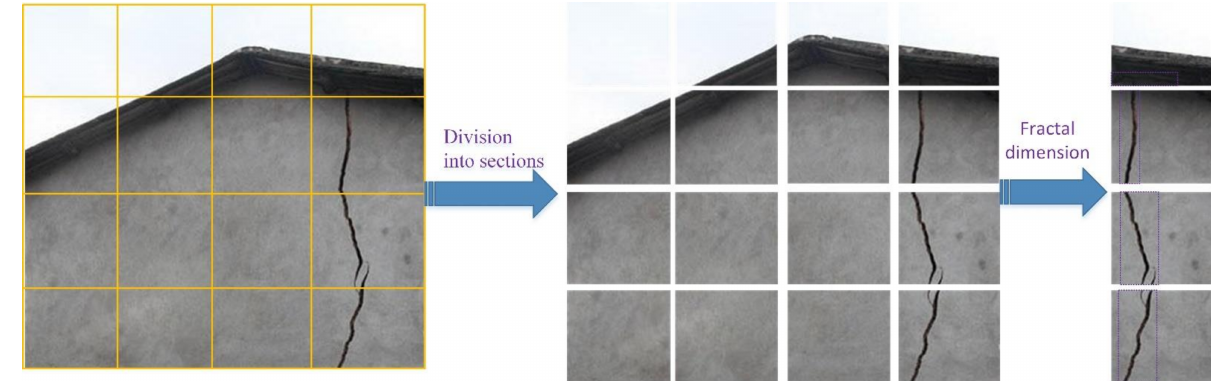
Figure 11. Steps of crack detection of larger area. Therefore, the proposed method mainly includes two steps: initial detection based on fractal dimension and fine segmentation based on UHK-Net network, as shown in Figure 12.